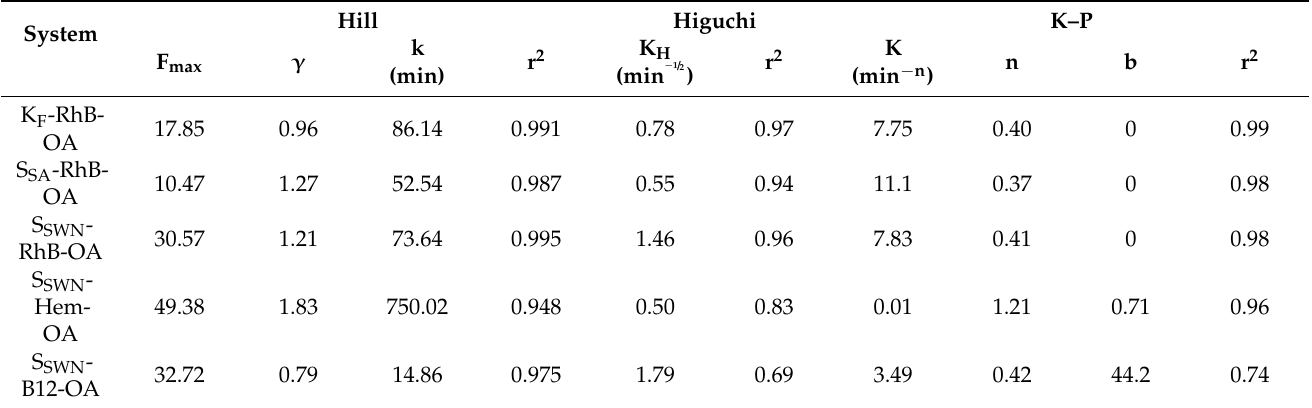
Table 4. Parameters and coefficients of determination (r 2 ) obtained by adjusting the data to each model Equations